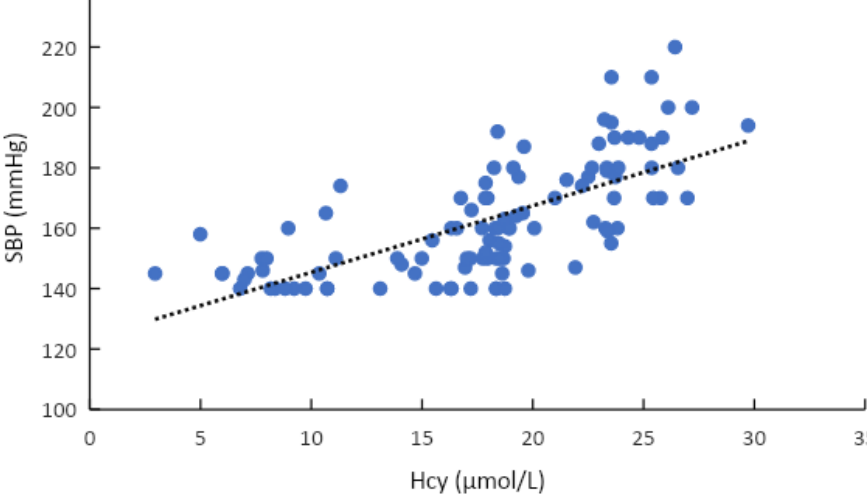
Figure 4. Plasma total homocysteine concentration and systolic blood pressure correlation.